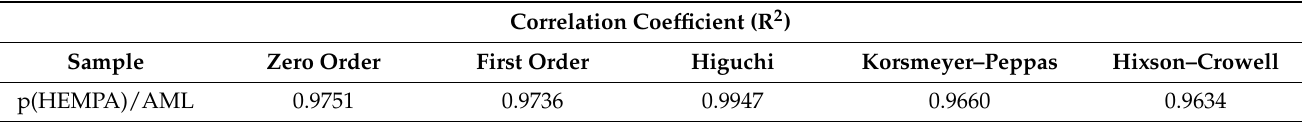
Table 1. Correlation coefficient (R 2 ) for various mathematical